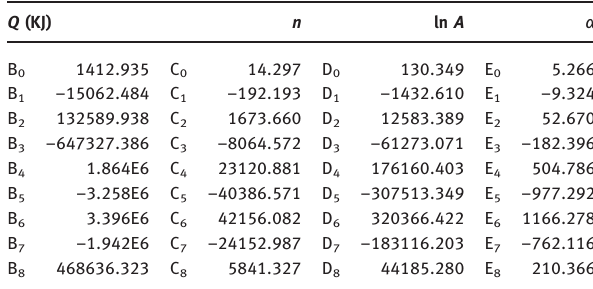
Table 1: The polynomial fit results of Q , n , ln A and α of 3Cr20Ni10W2 heat-resisting